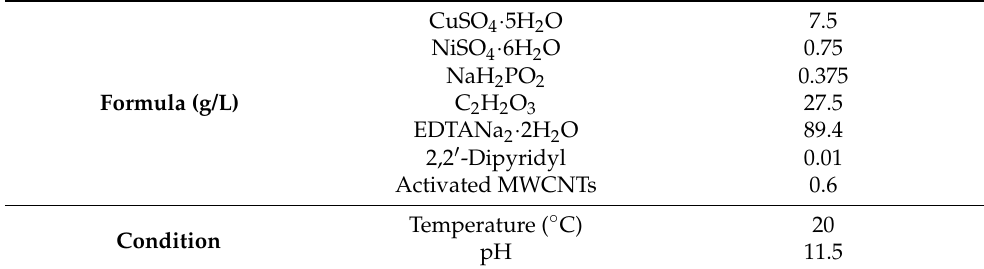
Table 3. Formula and conditions of electroless Ni&Cu